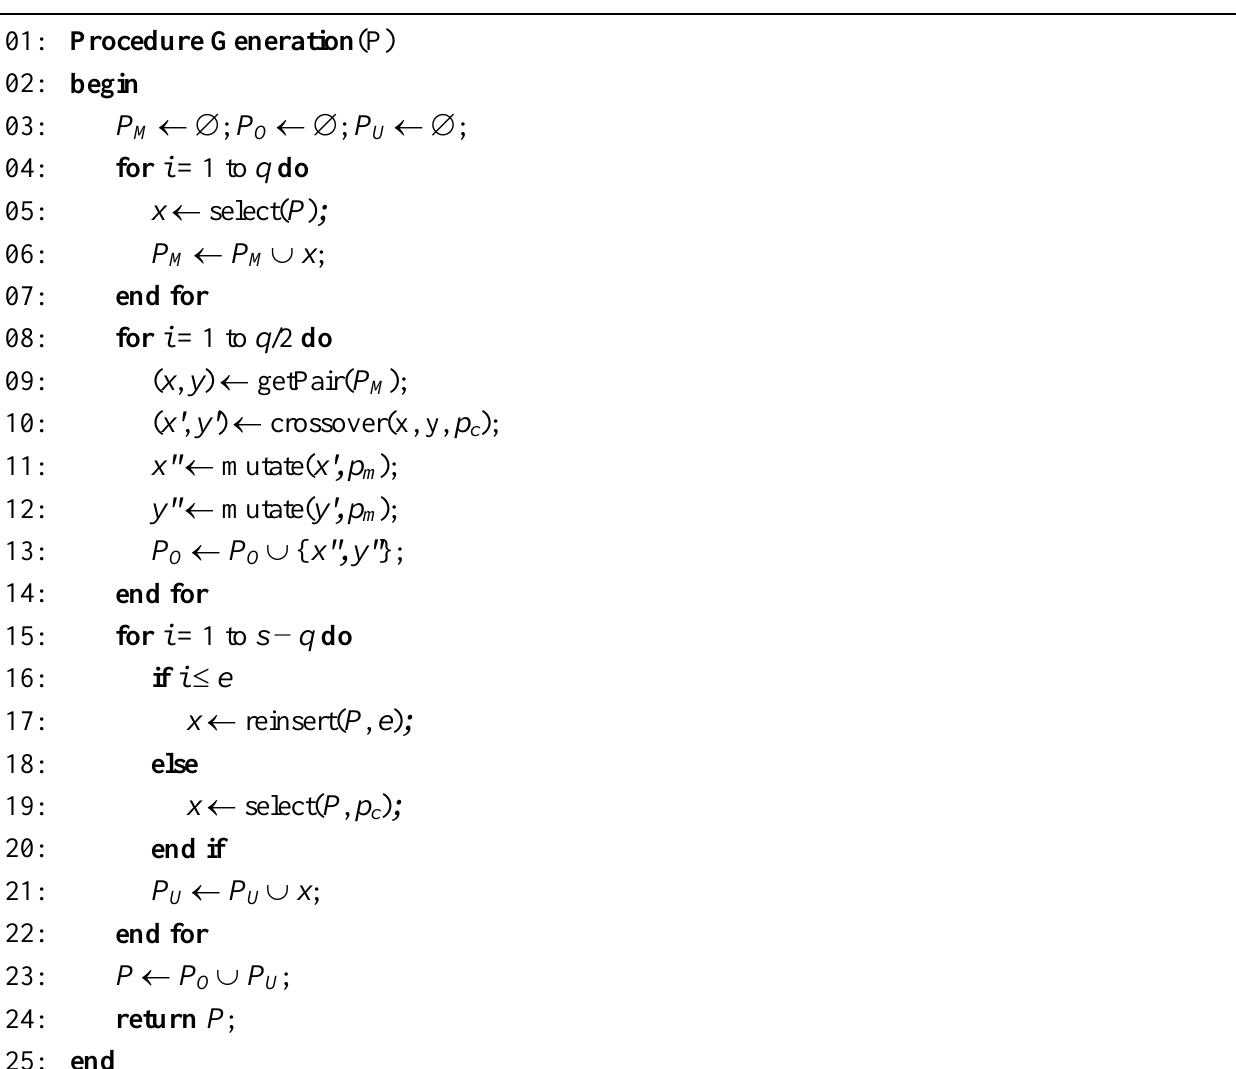
Algorithm 2: a generation of the genetic-based optimization